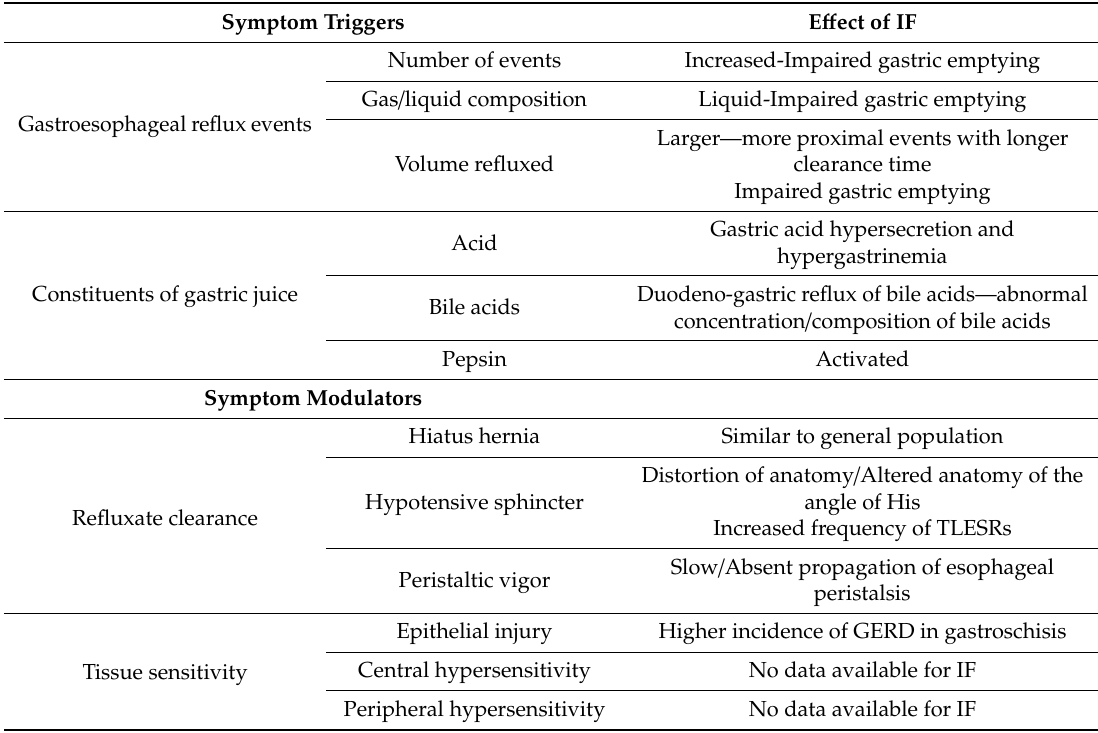
Table 2. Gastroesophageal reflux symptom triggers and modulators in intestinal failure. Symptom Triggers E ff ect of